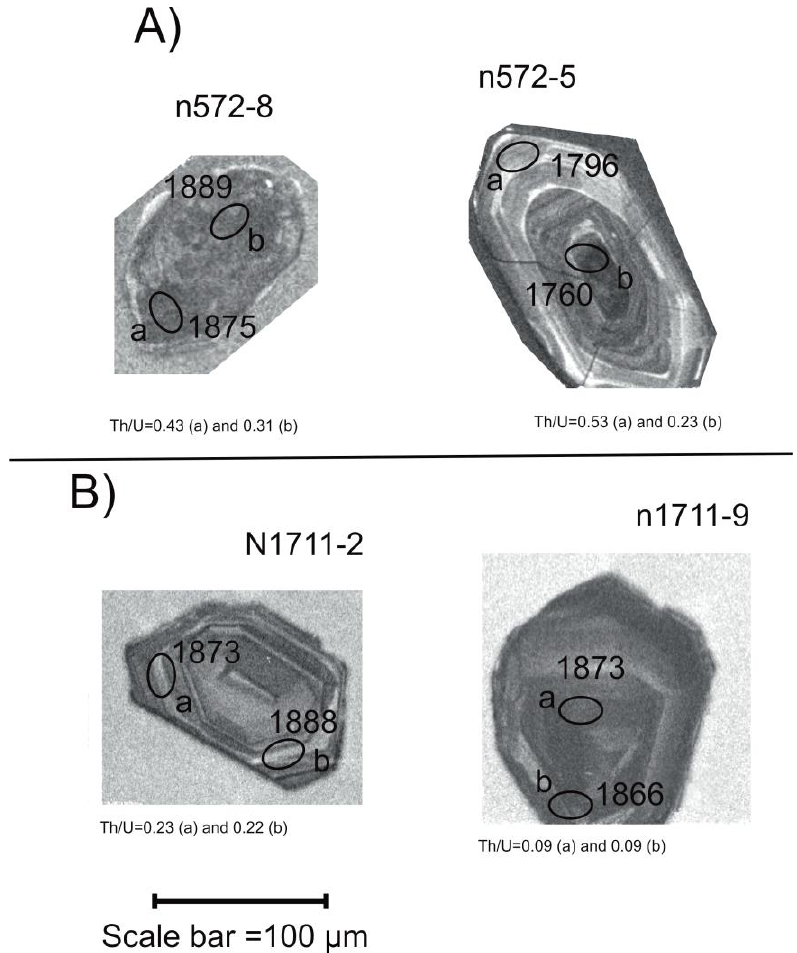
Figure 10. CL images and 207 Pb/ 206 Pb ages of zircons from Åkerberg. ( A ) Indistinct wispy zoning (# 8) and oscillatory zoned (# 5) gabbro zircons, with ages indicating an approximate magmatic and metamorphic age, respectively; ( B ) Oscillatory (# 2) and internal growth zoned (# 9) zircons from the granodiorite, with ages indicating a magmatic emplacement age.